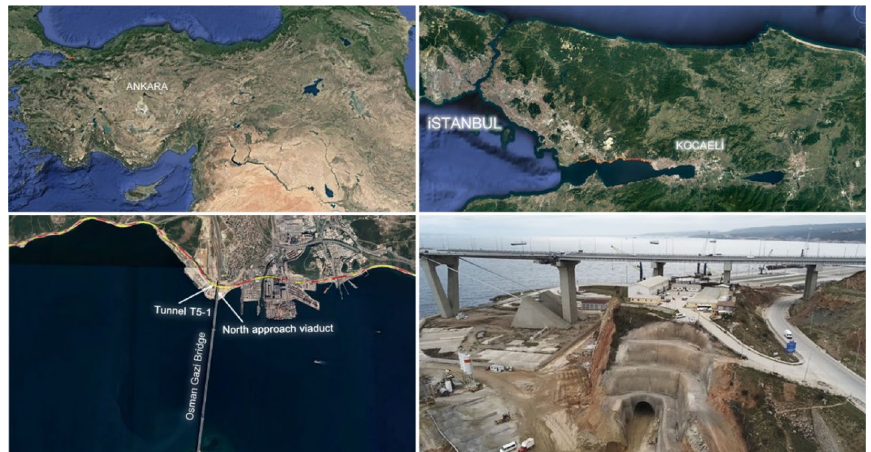
Fig. 1 Gebze-Köseköy project and T5-1 Tunnel location (Google